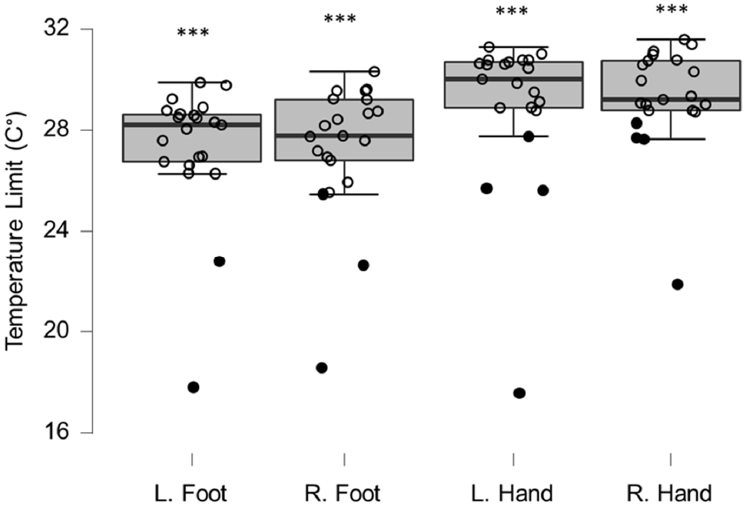
Figure 2. Box-plots for cold sensation limits. Lower and upper box boundaries represent the 25th and 75th percentiles, respectively. The line inside the box represents the median and the lower and upper whiskers represent the 10th and 90th percentiles. Filled circles represent values ≥ two standard deviations outside reference values. *** indicates a statistically significantly lower median values compared to the reference material, with a Bonferroni-corrected p -value corresponding to 0.001.